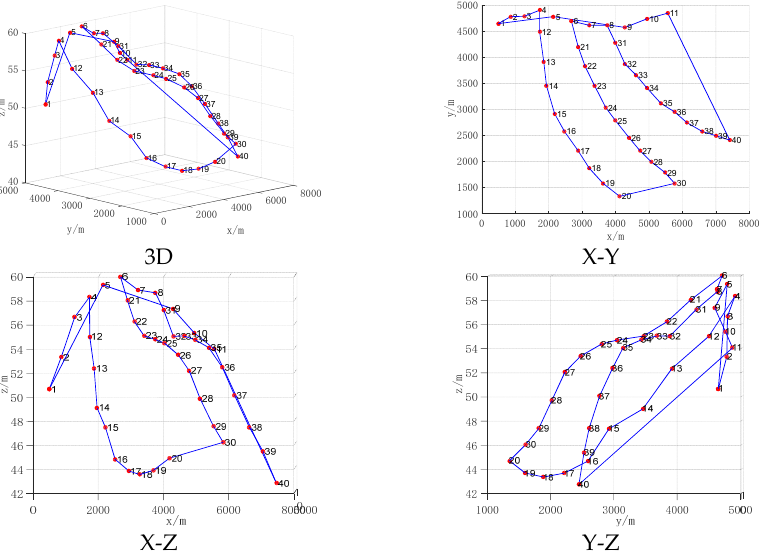
Figure 9. UAV conventional operation path diagram. Table 3. Total energy consumption of UAV flight under different paths. Load Weight (g)